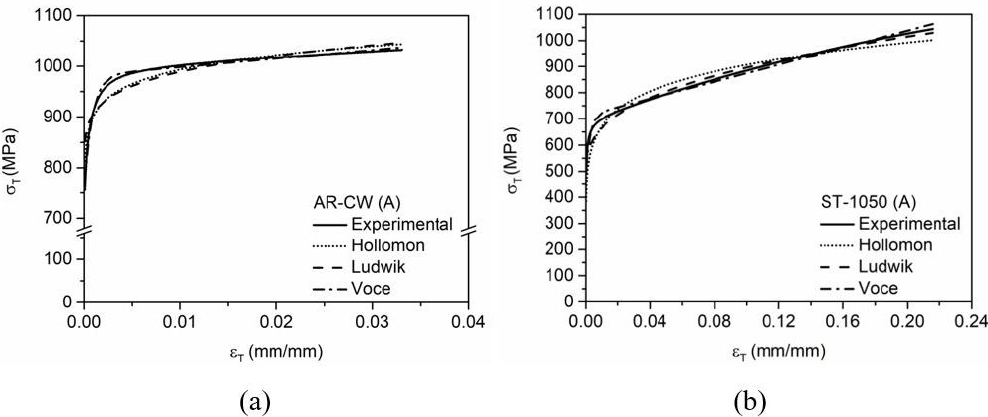
Figure 6. True stress-strain curves of specimens (a) AR-CW (A) and (b) ST-1050 (A), with the three Hollomon’s, Ludwik’s and Voce’s Table 6. Hollomon’s, Ludwik’s and Voce’s models of the flow curves σ versus ε results. Model